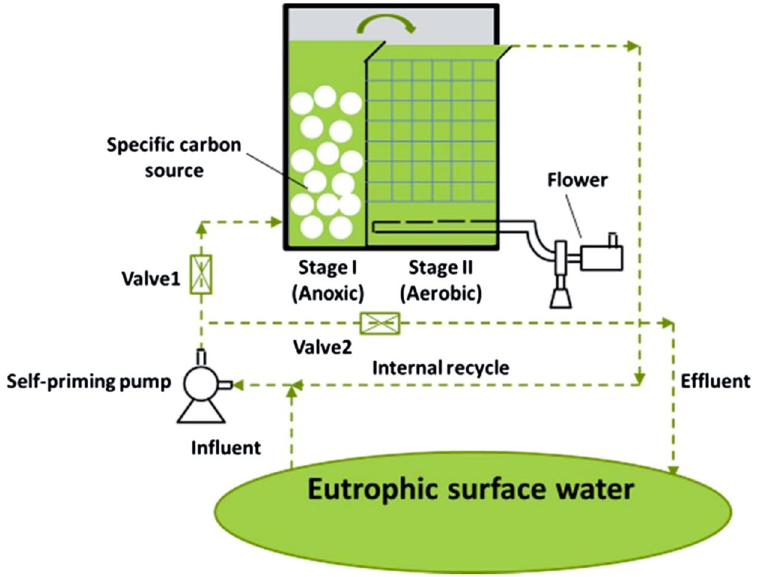
Figure 2. Constituents of